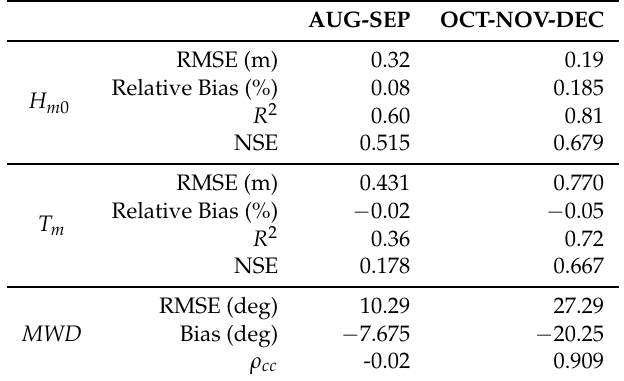
Table 2. Seasonal variability of goodness-of-fit metrics used for comparison of the ERA5 data with the observed wave data.